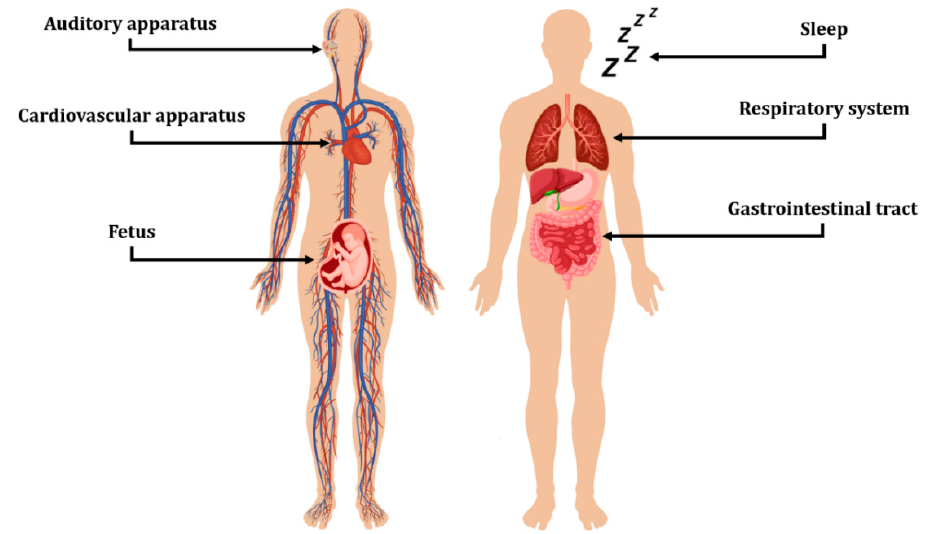
Figure 1. Fields of application for acoustic sensing devices covered in this work. The Figure was assembled using images from freepik.com and Vecteezy.com.